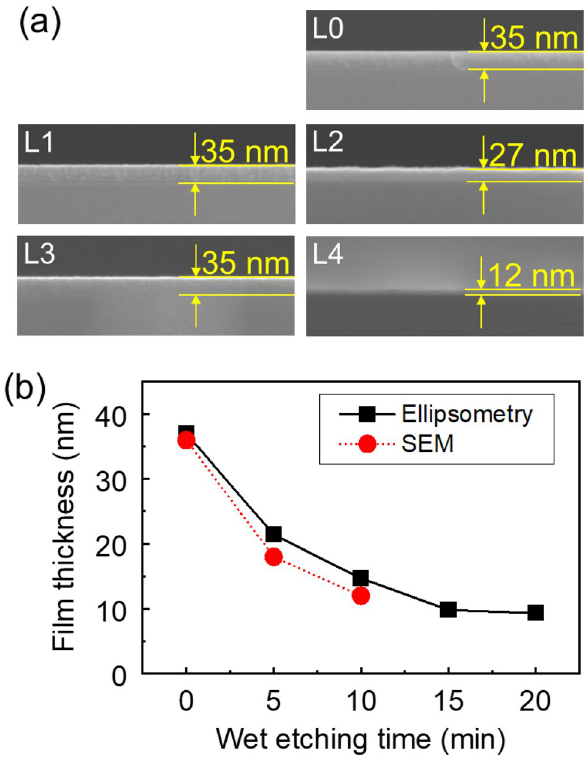
Figure 3. ( a ) SEM images of (L0) pristine TiAlC/Si sample and TiAlC/Si samples after wet etching in various solutions, (L1)